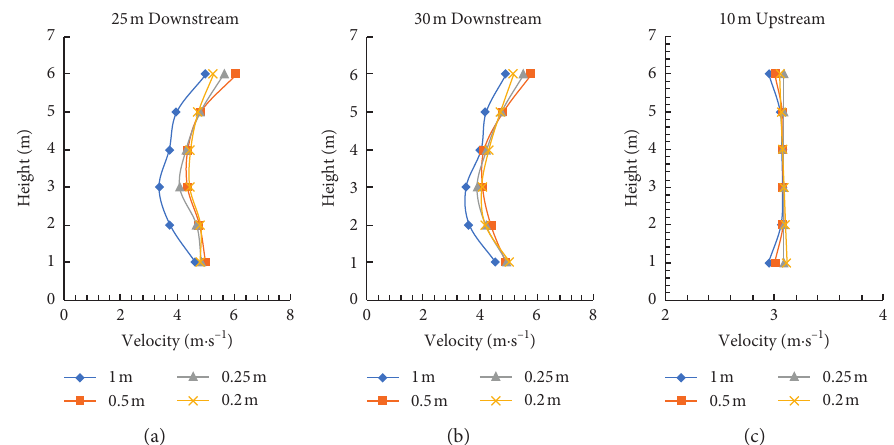
Figure 3: (a) Vertical distribution of the velocity at 25m downstream of fire source with different grid sizes. (b) Vertical distribution of the velocity at 30m downstream of fire source with different grid sizes. (c) Vertical distribution of the velocity at 10m upstream of fire source with different grid sizes.